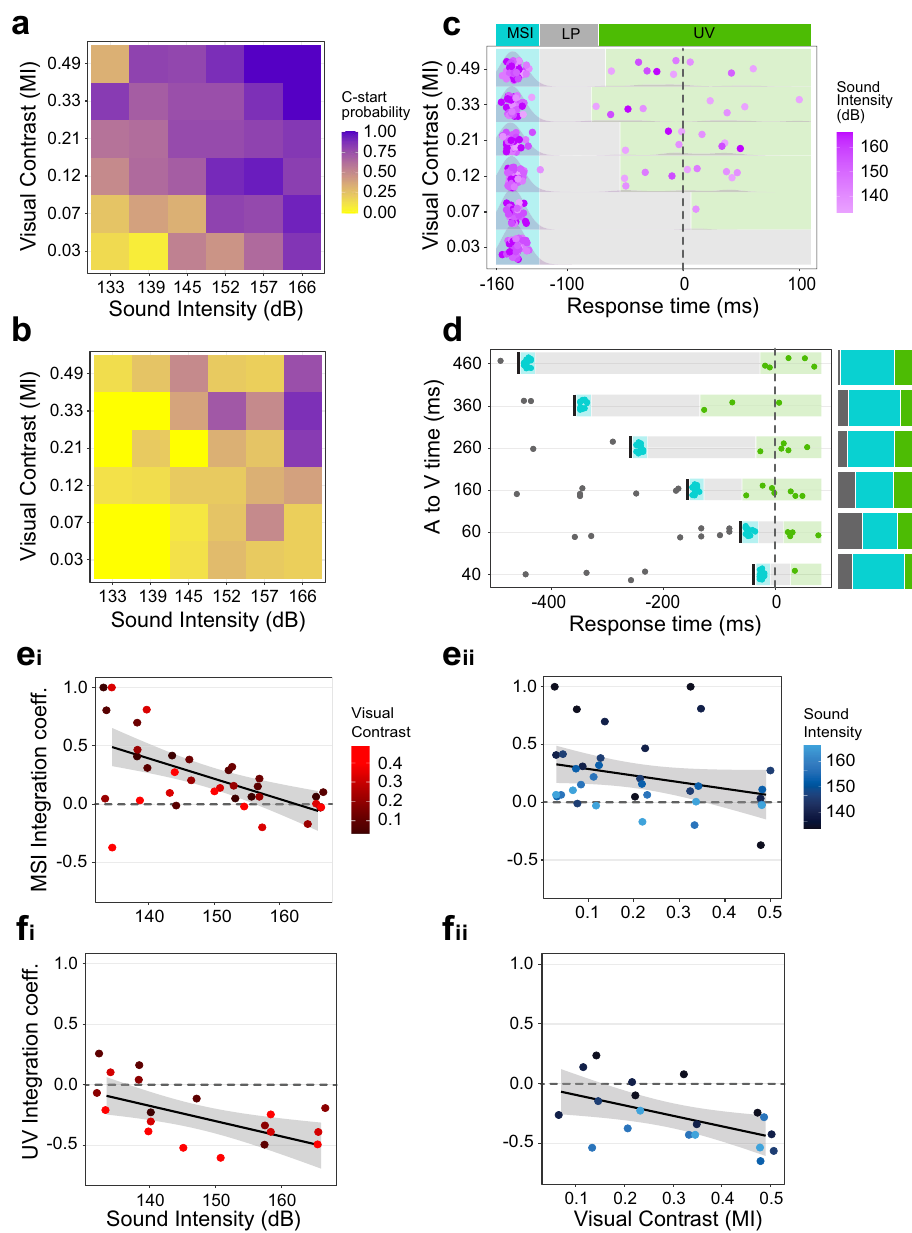
Figure 4. Multisensory integration enhances C-start probability and reduces response time. ( a ) C-start probability for non- freezing trials (n = 416, N = 80) and ( b ) freezing trials (n = 260, N = 65). ( c ) Response times and overlaid density distribution of C-starts during multisensory stimulation, grouped by visual contrast. Vertical scatter added for clarity. The purple shade of each dot represents the amplitude of the auditory stimulus presented 160 ms before the end of visual expansion (dashed line). The 250 ms period after the auditory stimulus shows three distinct phases: a high concentration of responses right after auditory presentation (MSI, cyan), an interval of low response probability (LP, light grey) and unisensory visual (UV, green) responses occurring around the end of visual expansion (n = 340, N = 85). ( d ) Multisensory response time was modulated by the delay between the auditory and visual stimuli. Sound intensity (149 dB) and visual contrast (MI 0.16) were invariant while the delay between auditory cue onset and end of loom was varied. Black bars signal the auditory stimulus. Response times follow the same pattern as in c , but the LP interval increases with the auditory-visual delay (n = 136, N = 39). Stacked bars show response probability before the auditory stimulus (dark grey), in the MSI (cyan) and UV (green) periods for each delay. ( e ) ICs during the MSI period as a function of sound intensity colored by visual contrast ( e i ) or as function of visual contrast ( e ii ) colored by auditory intensity (horizontal jitter is applied to ease visualization). ICs during the UV period as function of sound intensity and colored by visual contrast ( f i ) or as function of visual contrast colored by auditory intensity ( f ii ) (horizontal jitter applied to ease visualization). Coefficients were calculated only for combinations which yielded responses within this period (19 out of 36). In ( e–f) the horizontal dashed line represents no integration and the solid line and shaded area represent a linear fit to the data and 95% confidence